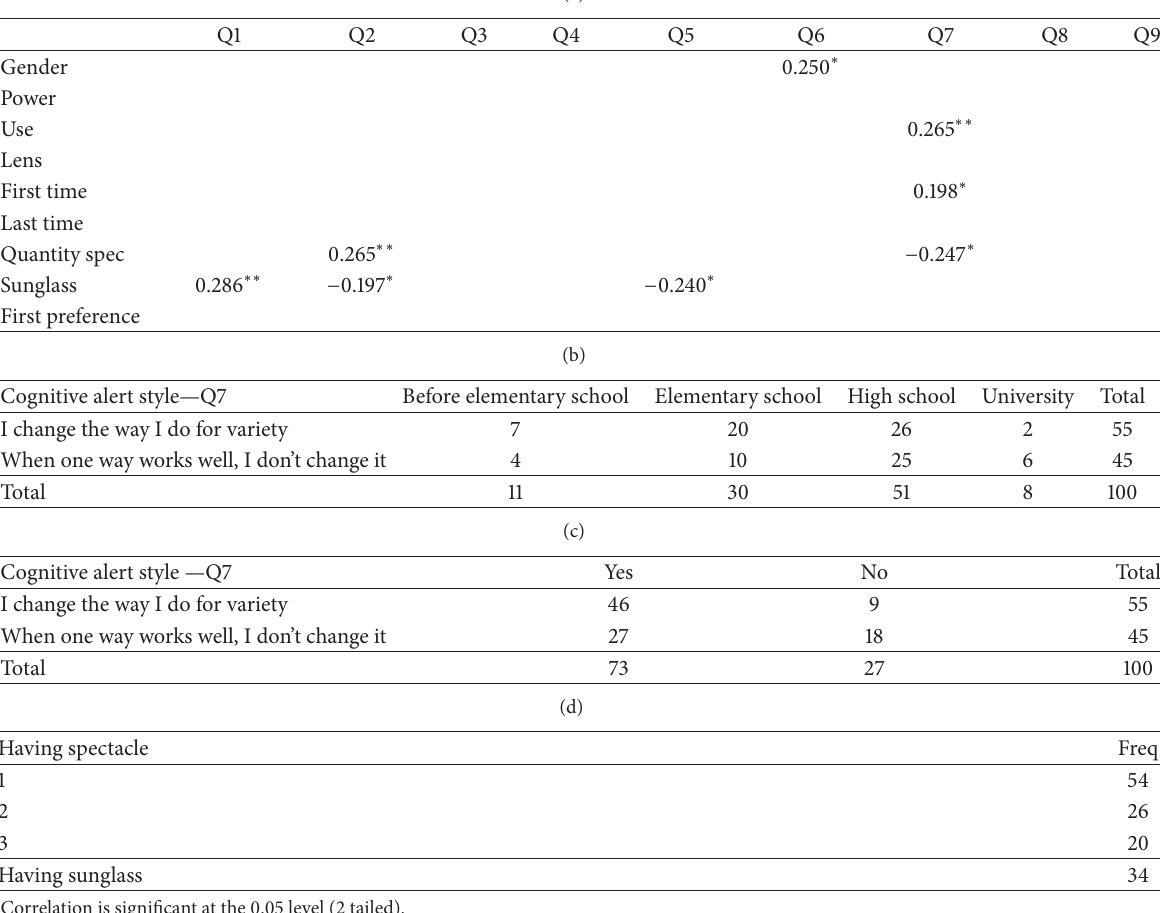
Table 10: Correlation between cognitive alert styles and students characteristics (spectacles